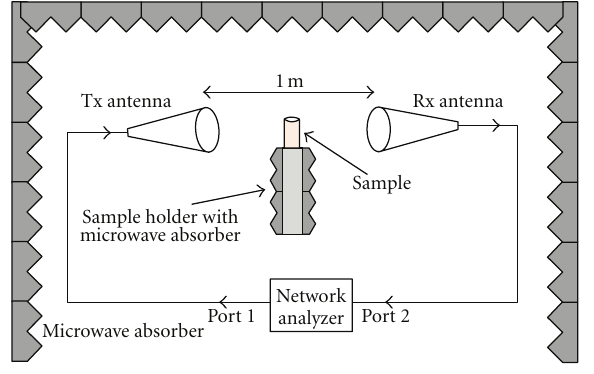
Figure 1: Measurement setup for samples.